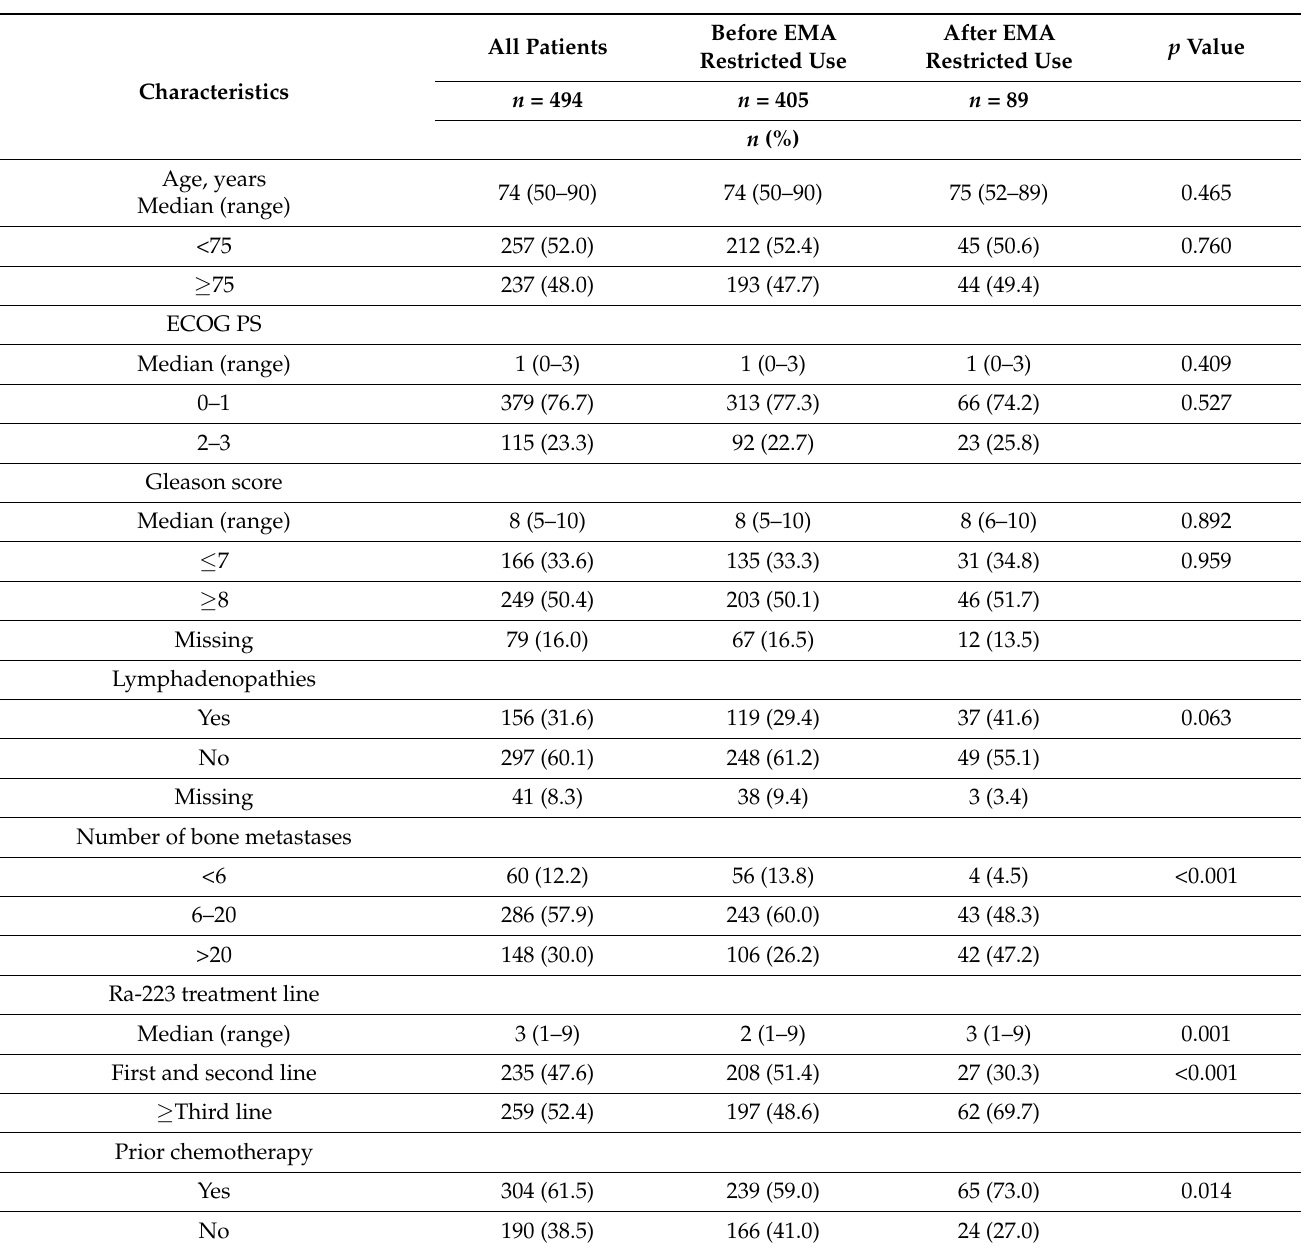
Table 1. Patients’